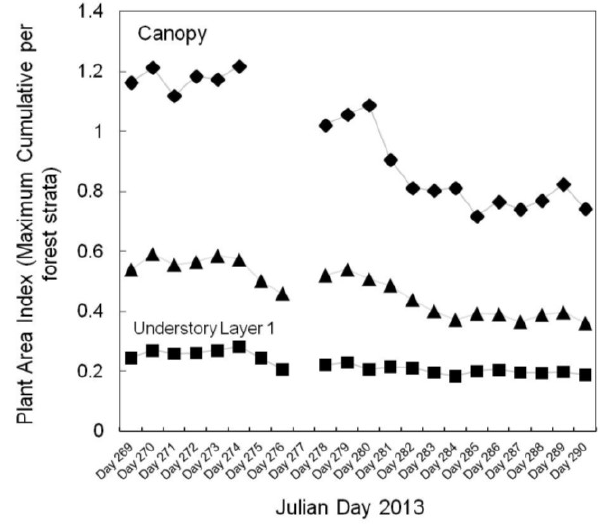
Figure 5. Time-series of maximum cumulative Plant Area Index (PAI) values calculated by the VEGNET IML during September 26 and October 17, 2013 for the understory, subcanopy (understory layer 2), and Canopy.